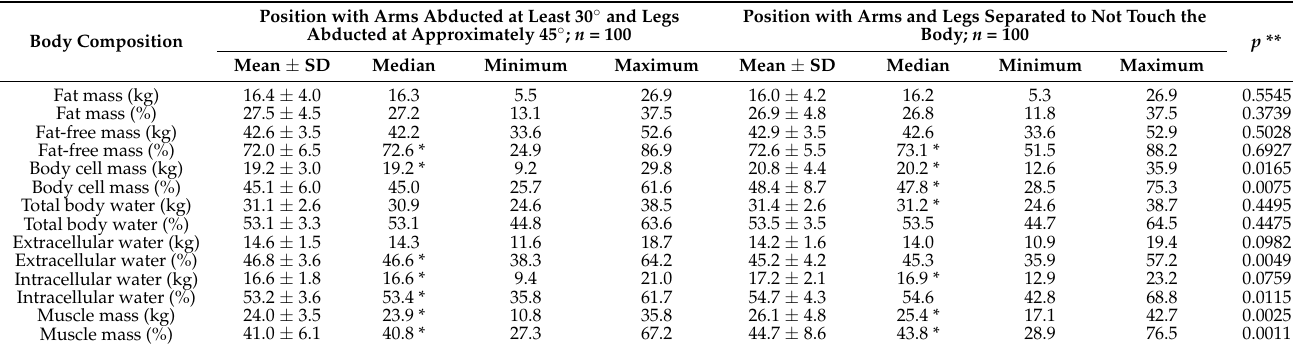
Table 1. Comparison of the body composition results in the studied group of Caucasian young normal body mass women measured in the follicular phase in various positions (with arms abducted at least 30 ◦ and legs abducted at approximately 45 ◦ ; with arms and legs separated to not touch the body). Position with Arms Abducted at Least 30 ◦ and Legs Position with Arms and Legs Separated to Not Touch the Abducted at Approximately 45 ◦ ; n = 100 Body; n = 100 p ** Body Composition Mean ± SD Median Maximum Mean ± SD Fat mass (kg)